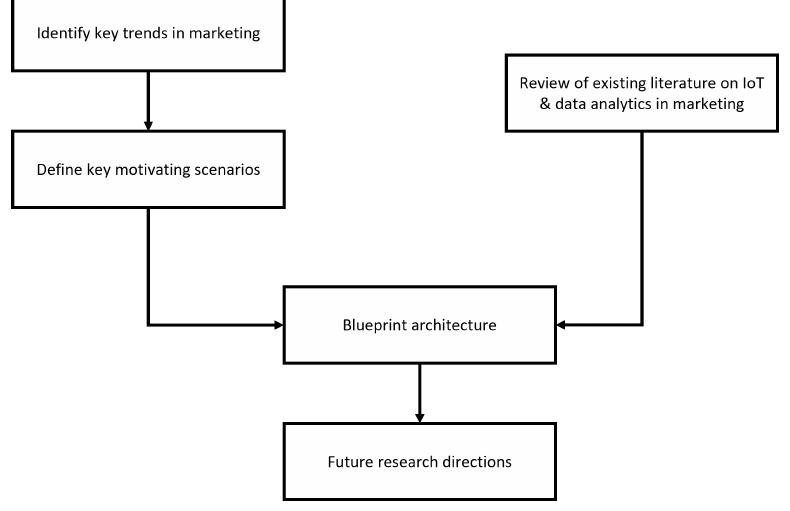
Figure 1. Methodology